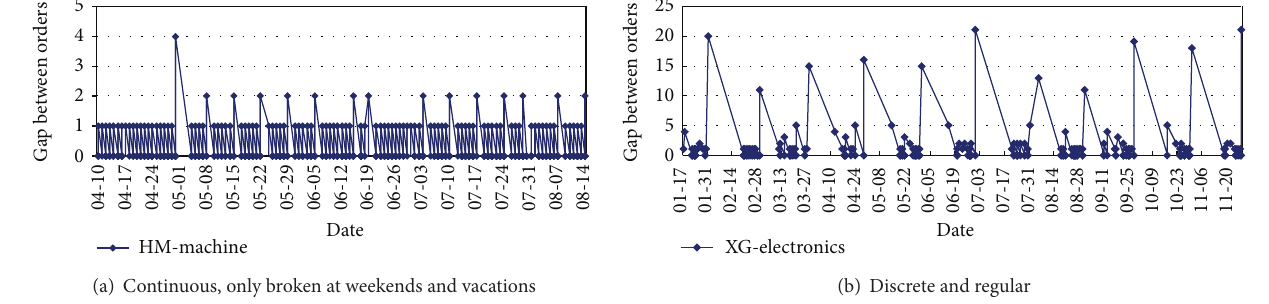
Figure 1: Gaps between regular orders in days.